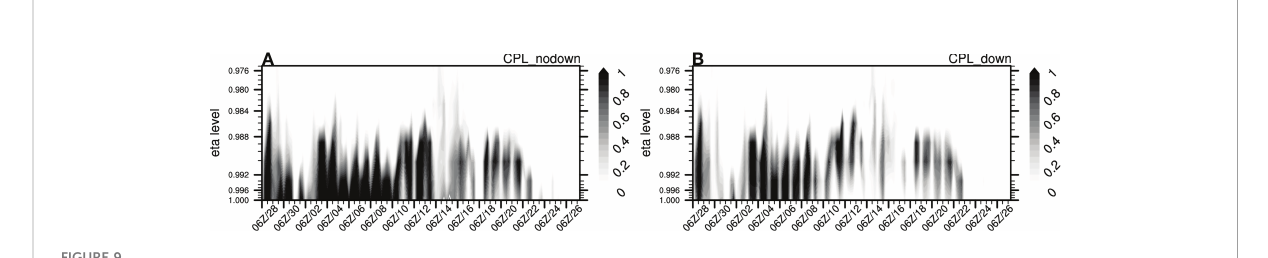
FIGURE 9 Time series of the vertical structure of cloud fractions passing through the Yellow Sea (36.5 – 39.0° N, 124.0° E) for the (A) CPL_nodown and (B) CPL_down simulations for the 1994